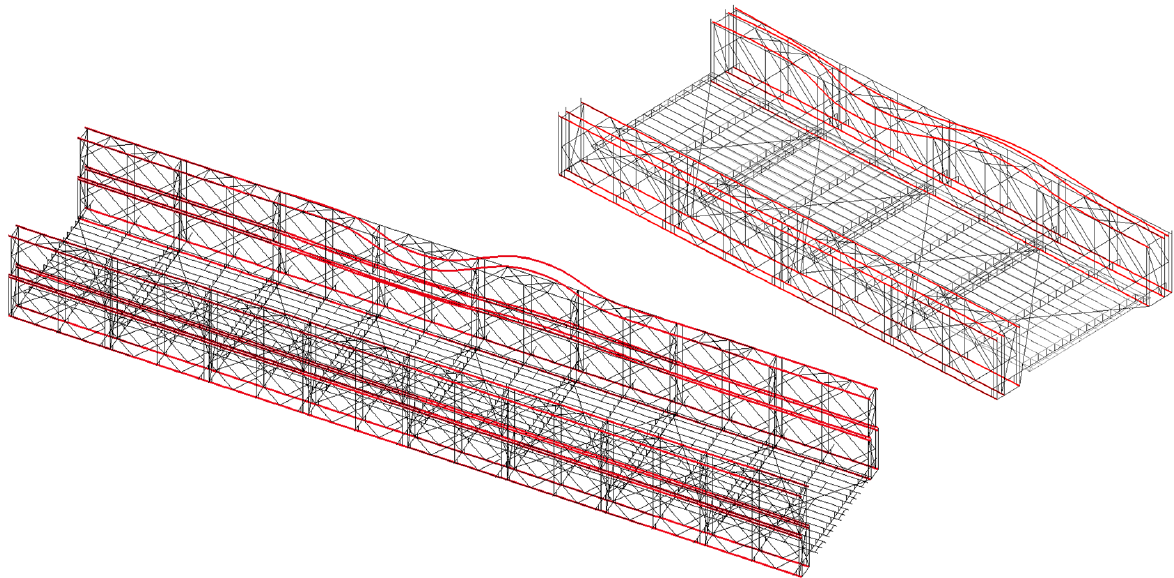
Figure 15. Examples of buckling modes of top chords in the case of BB composed as TS ‐ 12 (top right) and DD ‐ 24 (bottom left).